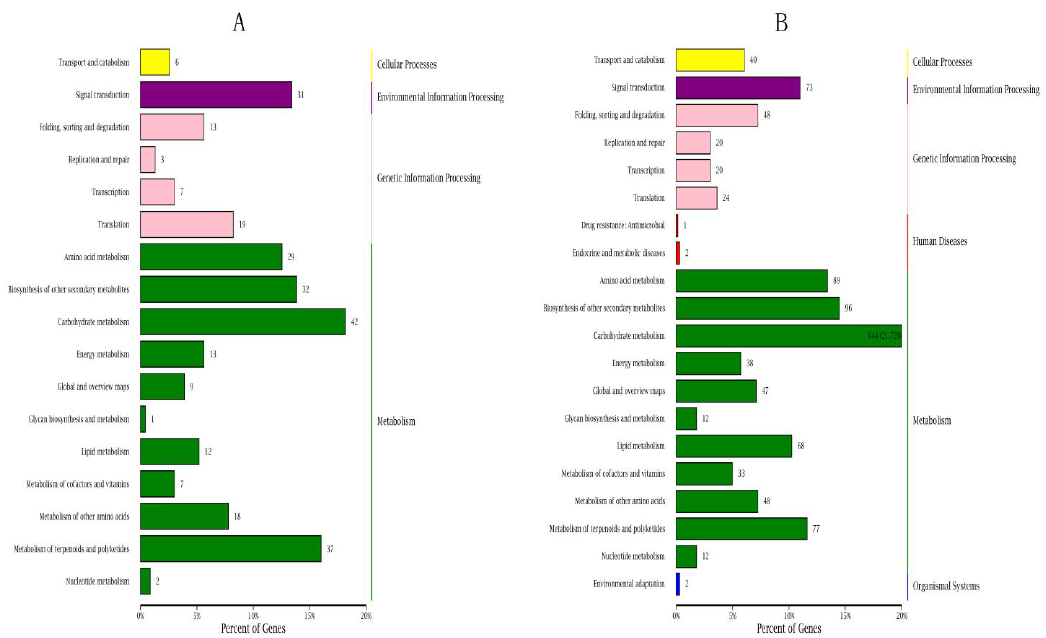
Figure 6. KEGG pathway classification of DEGs during the growth period of weeping peach branches: ( A ) comparison of HCZ and XH at the early stage of branch growth (HCZS1 vs. XHS1); ( B ) comparison of HCZ and XH at the late stage of branch growth (HCZS2 vs. XHS2). HCZ — weeping peach ‘Hongchuizhi’ variety; XH—standard peach ‘Xiahui 6 ’ variety.